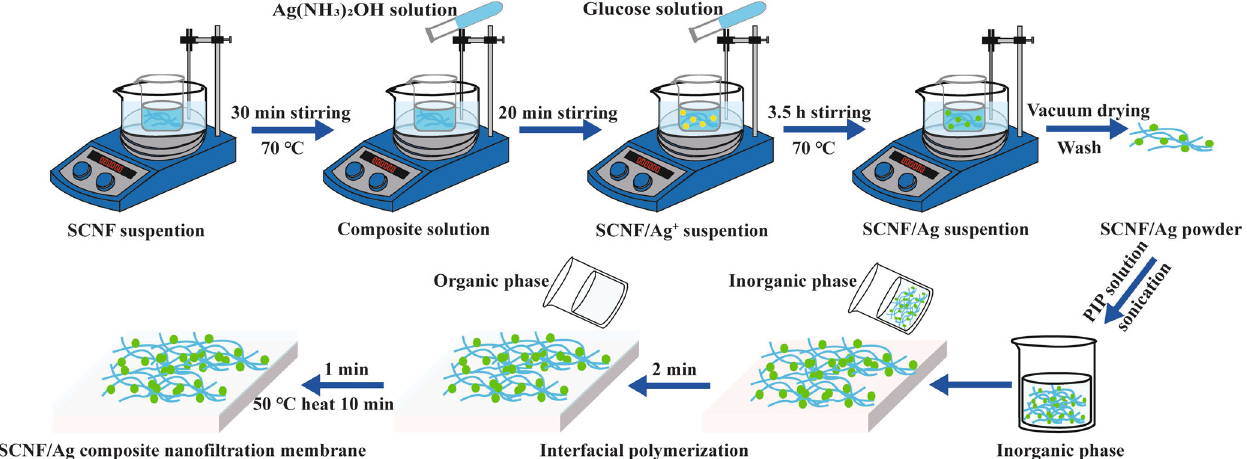
Fig. 10 Preparation process of SCNF/Ag nanocomposites and SCNF/Ag composite NF